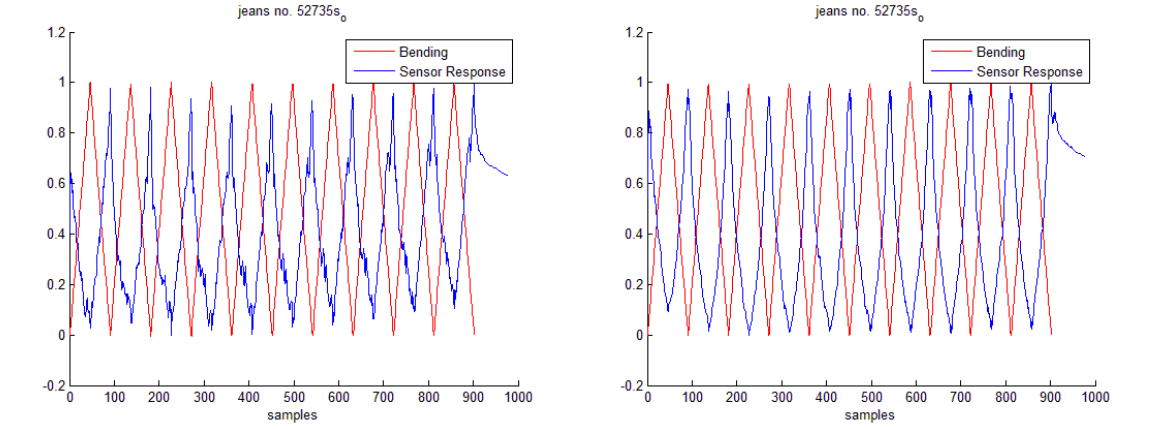
Figure 9. Normalized alignment, simple outer fold: ( left ) un-insulated case; ( right ) insulated